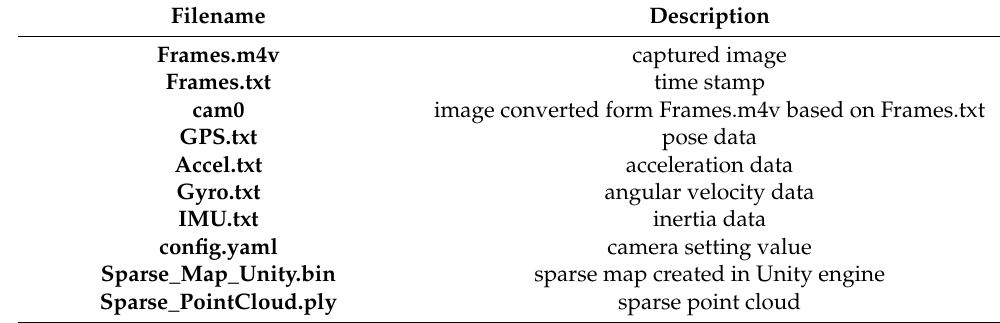
Table 5. SLAM performance-related